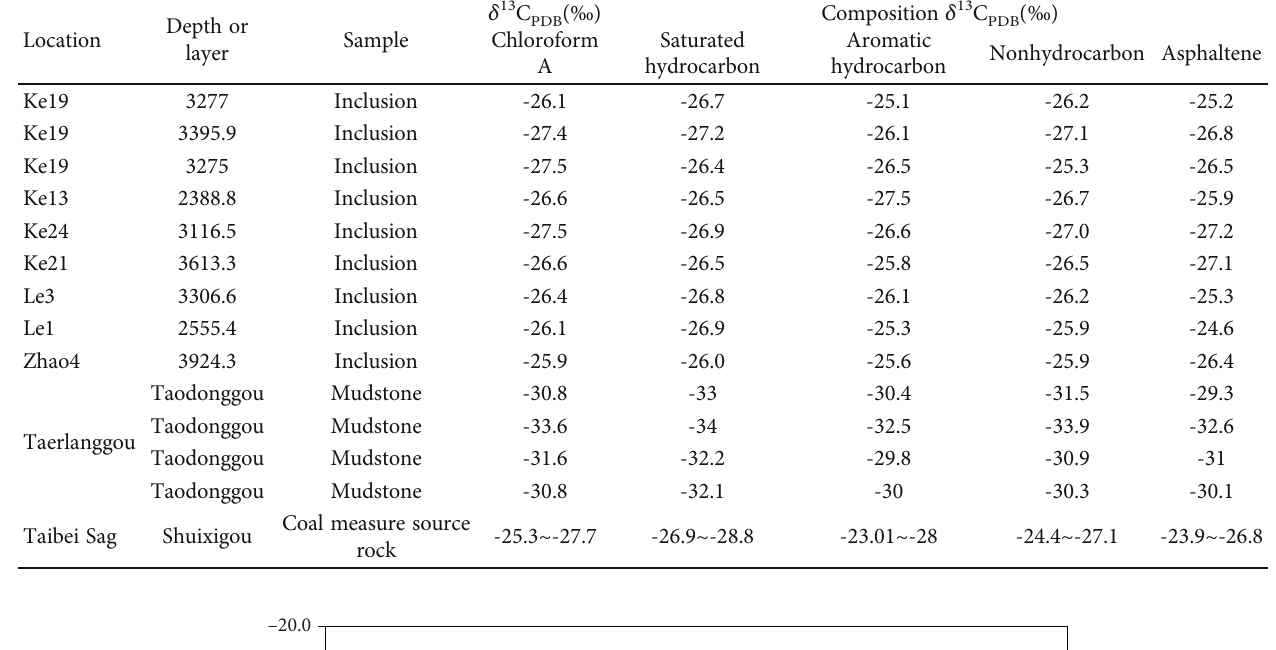
Table 2: Chloroform asphalt and its group component carbon isotope of the inclusions and source rocks. Note: data of coal measure source rock in Taipei depression come from reference [30].